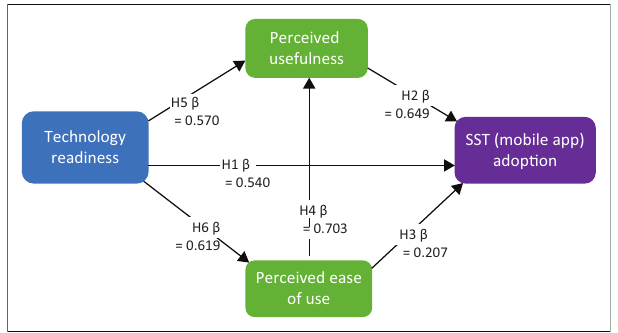
FIGURE 2: Regression analysis results for the influence of technology readiness and perceptions regarding mobile application